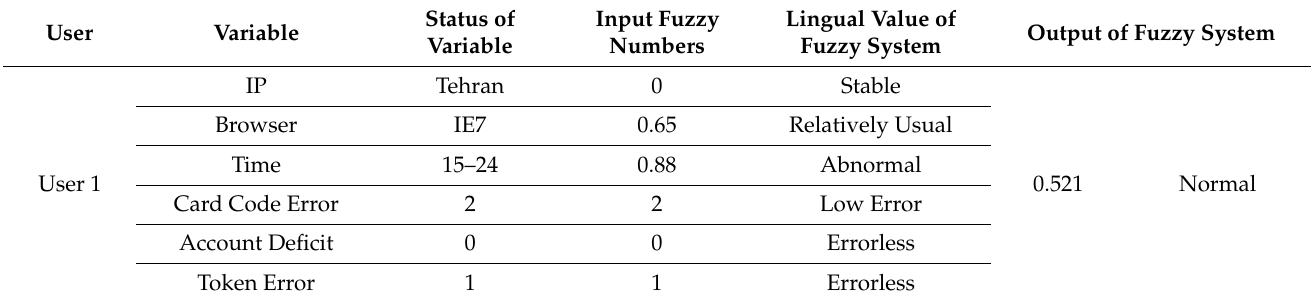
Table 10. Status of variables for user 1 (source: research